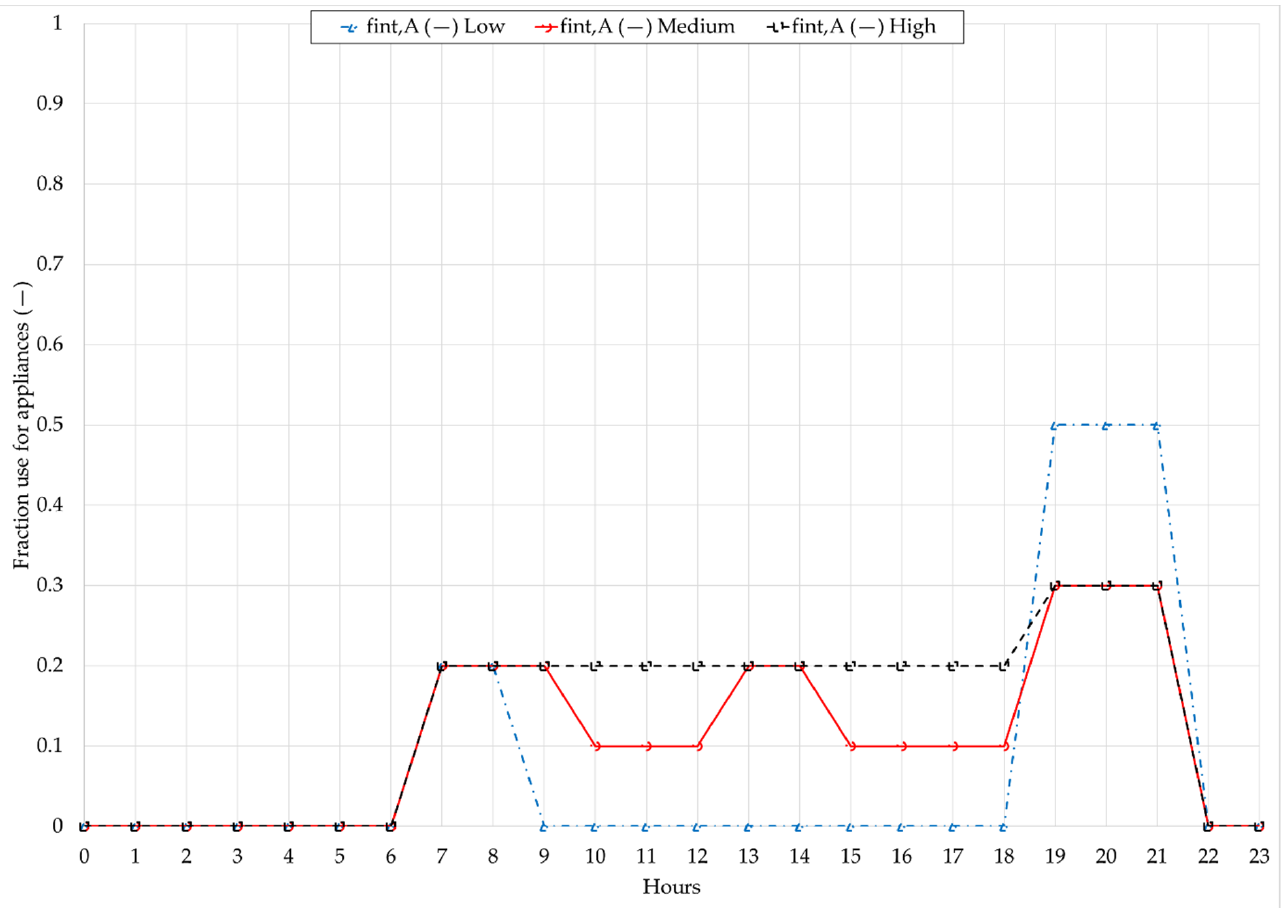
Figure 7. Fraction of appliance uses for the different scenarios analysed (low, medium, and high).